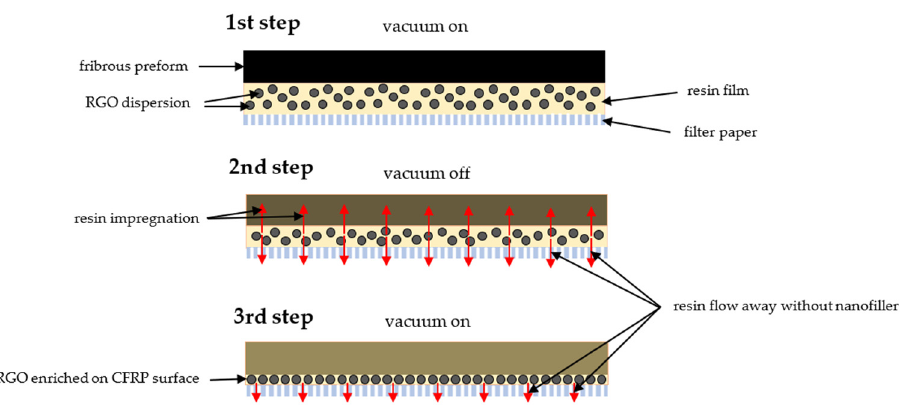
Figure 4. Schematic of the resin film infusion (RFI) process to accumulate RGO on the carbon-fiber- reinforced polymer (CFRP) surface (source: own work on the basis of [61]).